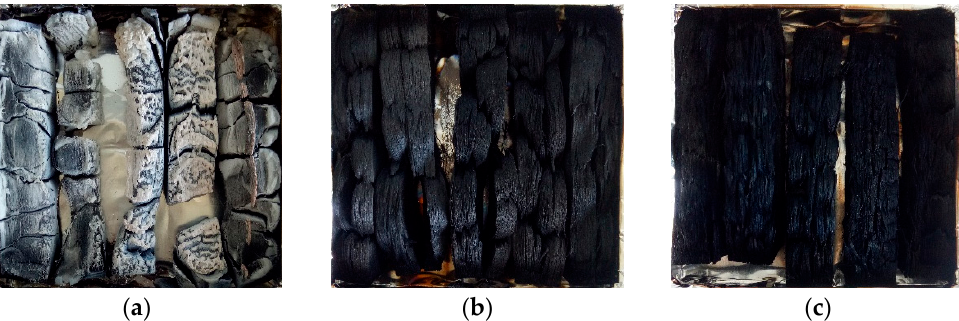
Figure 5. Digital pictures of ( a ) untreated wood, ( b ) W-Si and ( c ) W-Si/B residues.